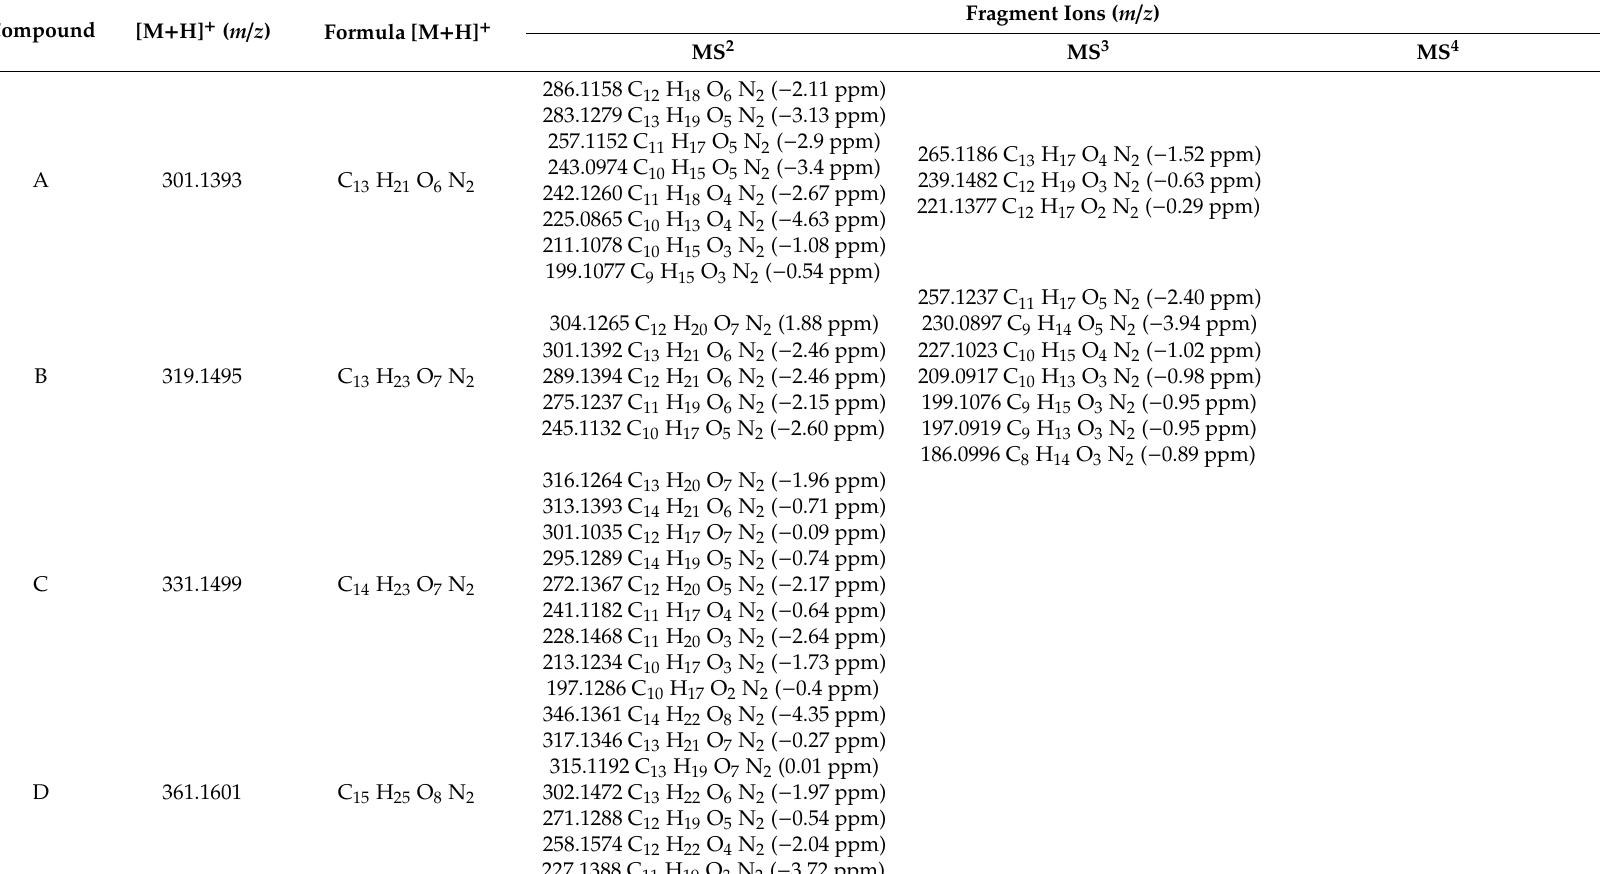
Table 5. Structural elucidation of novel MAAs. Fragment ions detected in MS 2 , MS 3 and MS 4 fragmentation were reported for the seven masses annotated from A–G.